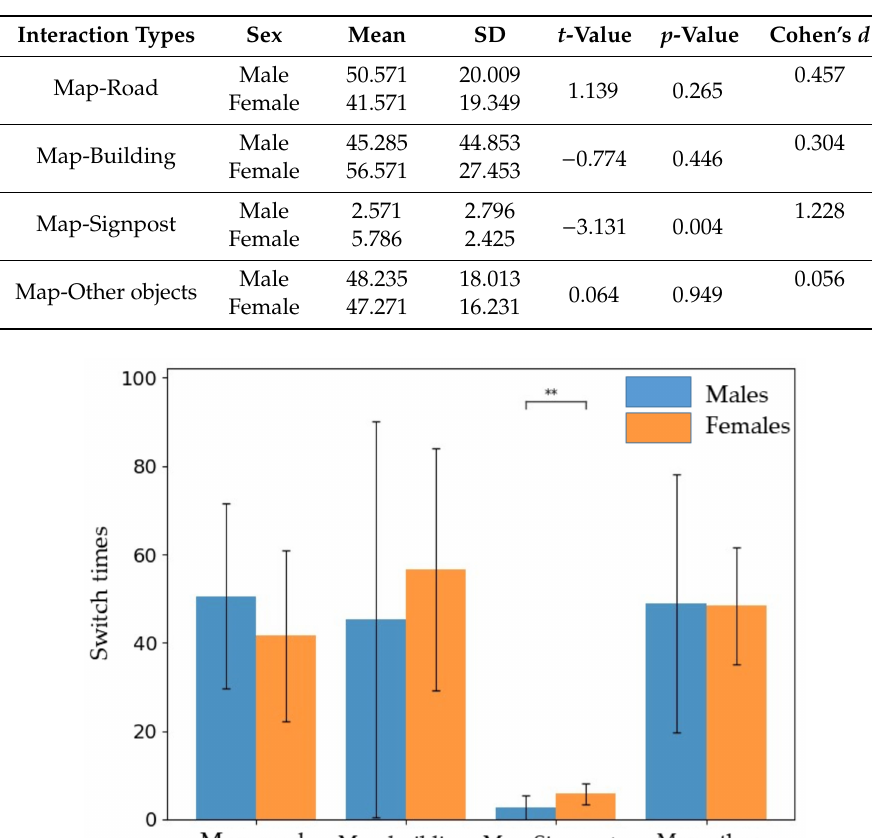
Table 6. The interaction between the map and other AOIs.